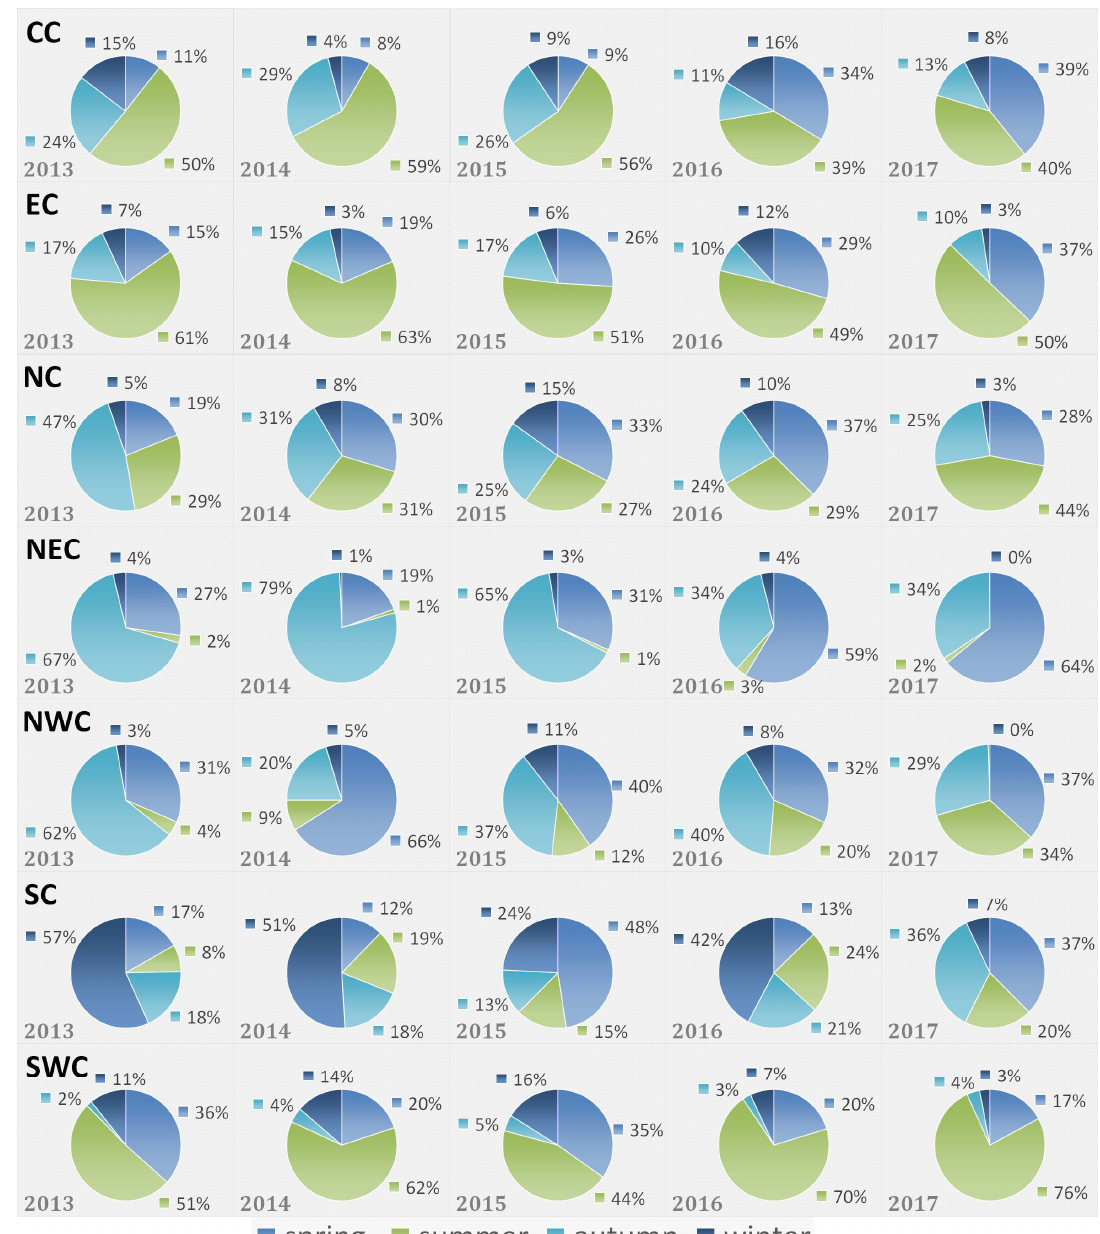
Figure 9. Seasonal variations of crop residue burning spots in different regions of study area.